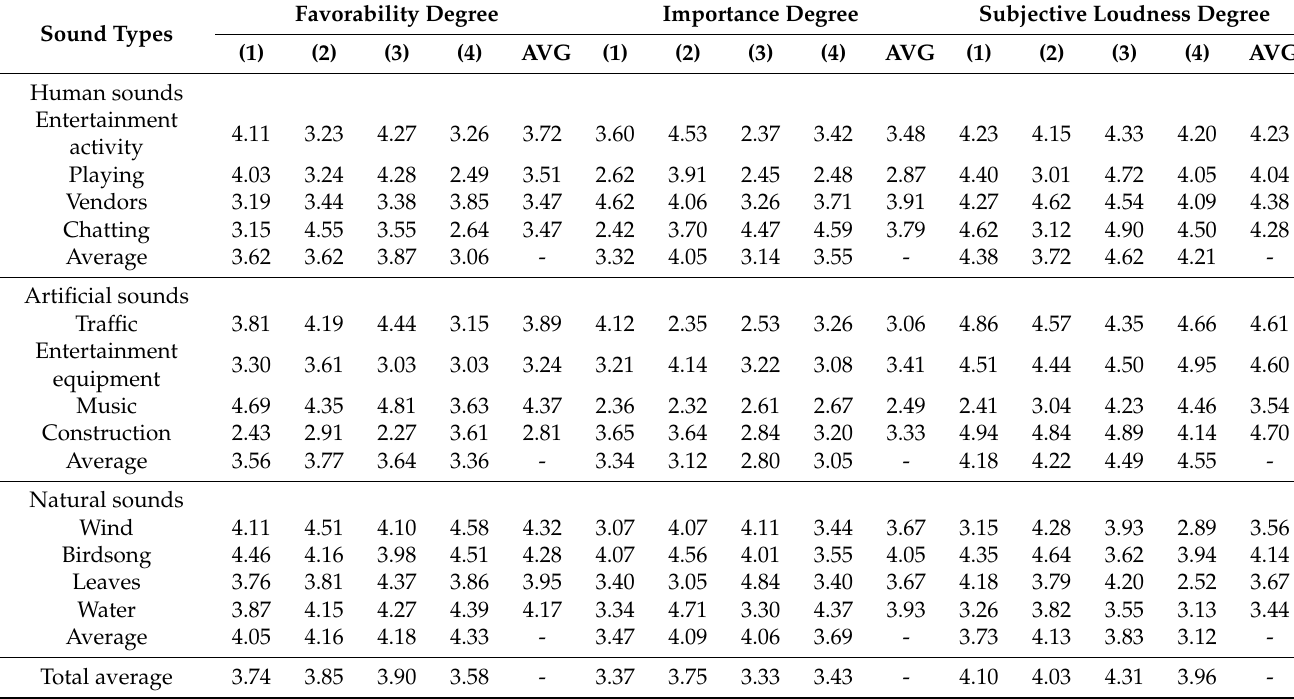
Table 6. The evaluation results of the degree of favorability, importance, and subjective loudness of